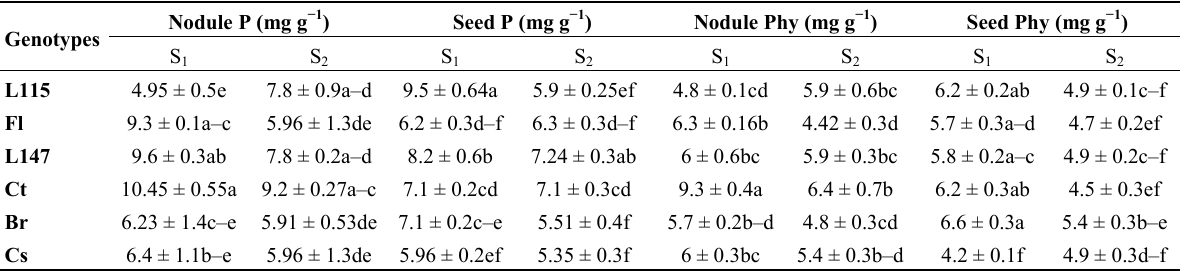
Table 1. Phosphorus (P) and phytate (Phy) contents in nodules and seeds of six common bean genotypes grown under sufficient P (S six